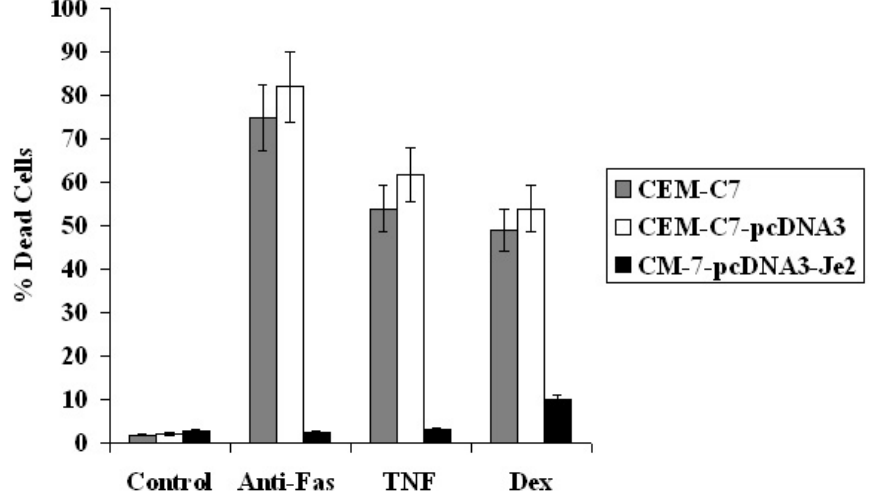
FIGURE 1. Je2 overexpression inhibits CD95-, TNF α -, and dexamethasone-mediated cell death. CEM- C7 cells were stably transfected with pcDNA3 vector alone or pcDNA3-Je2. Cells (2 × 10 5 cells/ml) were incubated in the presence of 5 ng/ml anti-CD95, 50 ng/ml TNF α, and 10 μ M dexamethasone for 48 h. The percentage of dead cell number was determined by nigrosin dye